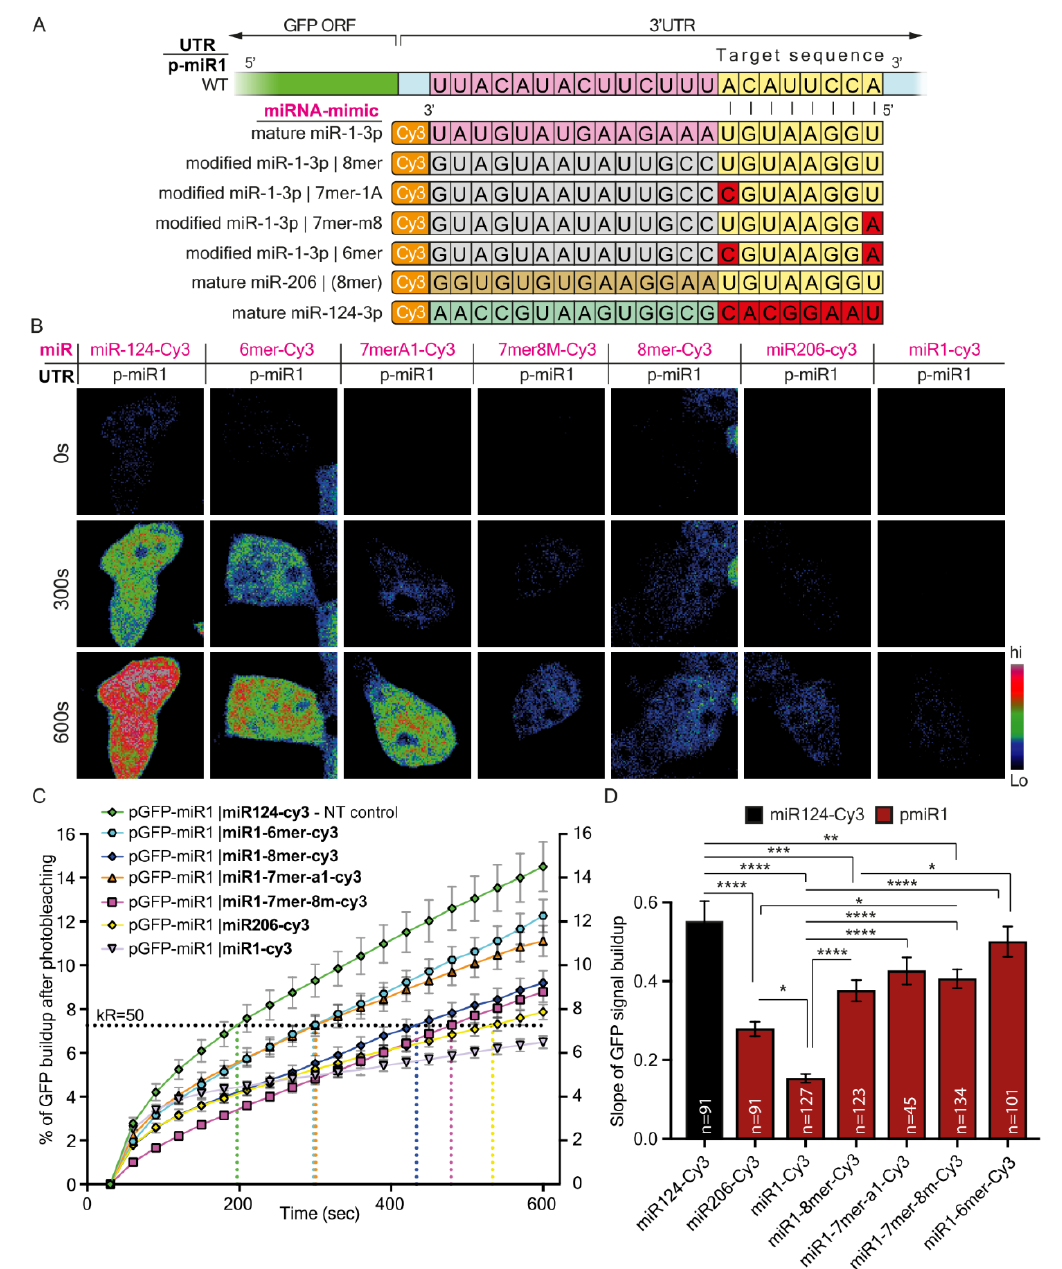
Figure 3. Modified miR-1-3p mimetics differentially regulate protein synthesis of WT 3′UTR. ( A ) A schematic illustration of the experimental setup. Four distinct miRNA mimetics containing mutations in their seed sequence, which mimic the canonical sites usually found on target 3′UTR, and three more mature miRNAs (Cy1-miR-1, Cy3-miR-206, Cy3-miR-124) were each co-transfected into 293T cells, together with dGFP expression plasmid containing the full complementary sequence for miR-1-3p. Green indicates the GFP coding sequence (CDS); light blue indicates the 3′UTR of dGFP; nucleotides labeled in pink indicate nucleotides in full complementation to mature miR-1; nucleotides labeled in grey indicate random nucleotides not complementing the full sequence of mature miR-1, miR-206,and miR-124; nucleotides labeled in yellow and red indicate nucleotides in the miRNA target sequence that are complementary and non-complementary, respectively, to the seed sequence; nucleotides labeled in light green and brown indicate sequence differences between miR-124, miR-206, and miR-1. ( B ) Representative images of dGFP in 293T cells carrying WT miR-1-3p canonical sites in 3′UTR, but co -transfected with modified miR-1-3p variants. The images show three time points for each cell: 0 minutes, 5 minutes, and 10 minutes after photobleaching. ( C ) A graph showing the cumulative percent of fluorescence of dGFP during the 10 minutes following